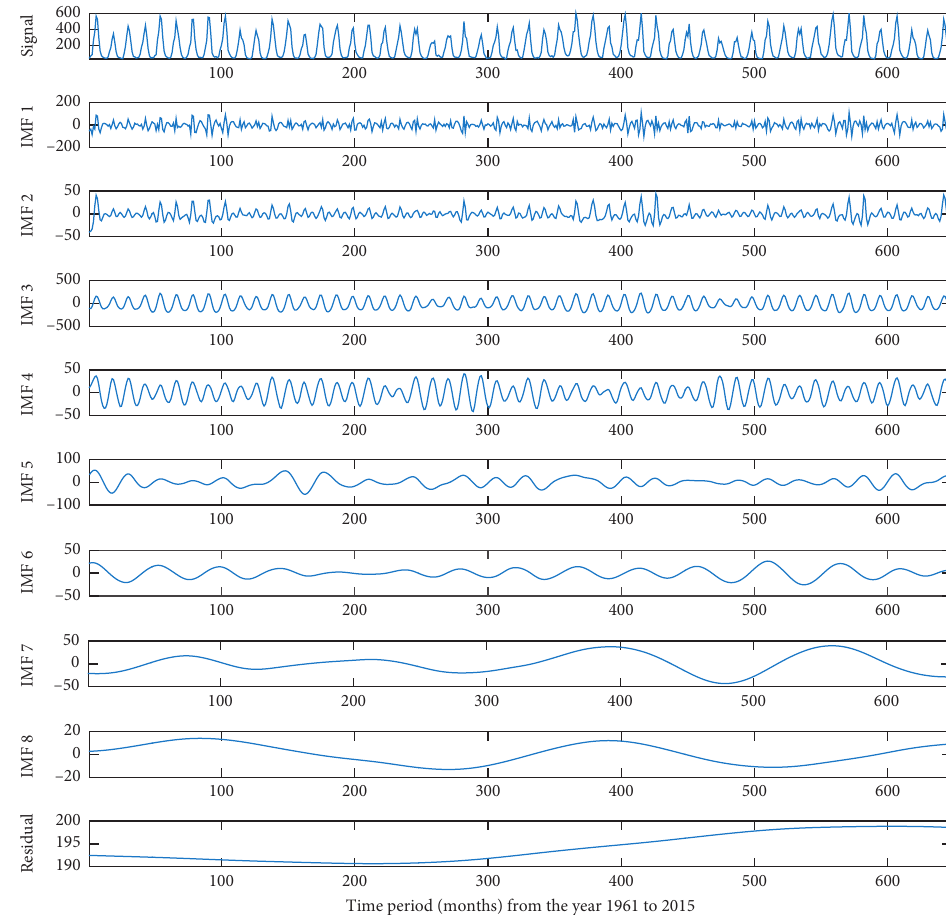
Figure 6: Decomposition of runoff time series using CEEMDAN.